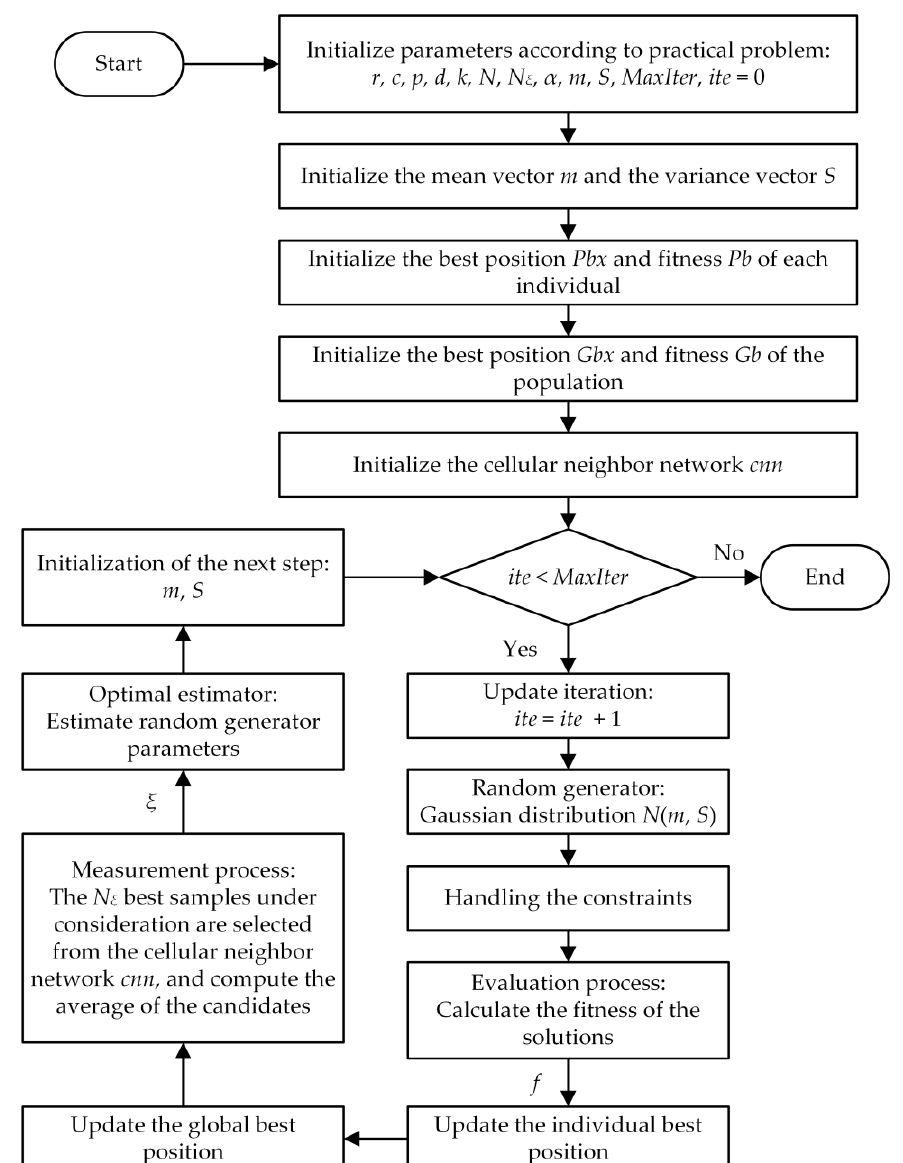
Figure 3. The flowchart of the IHKA.